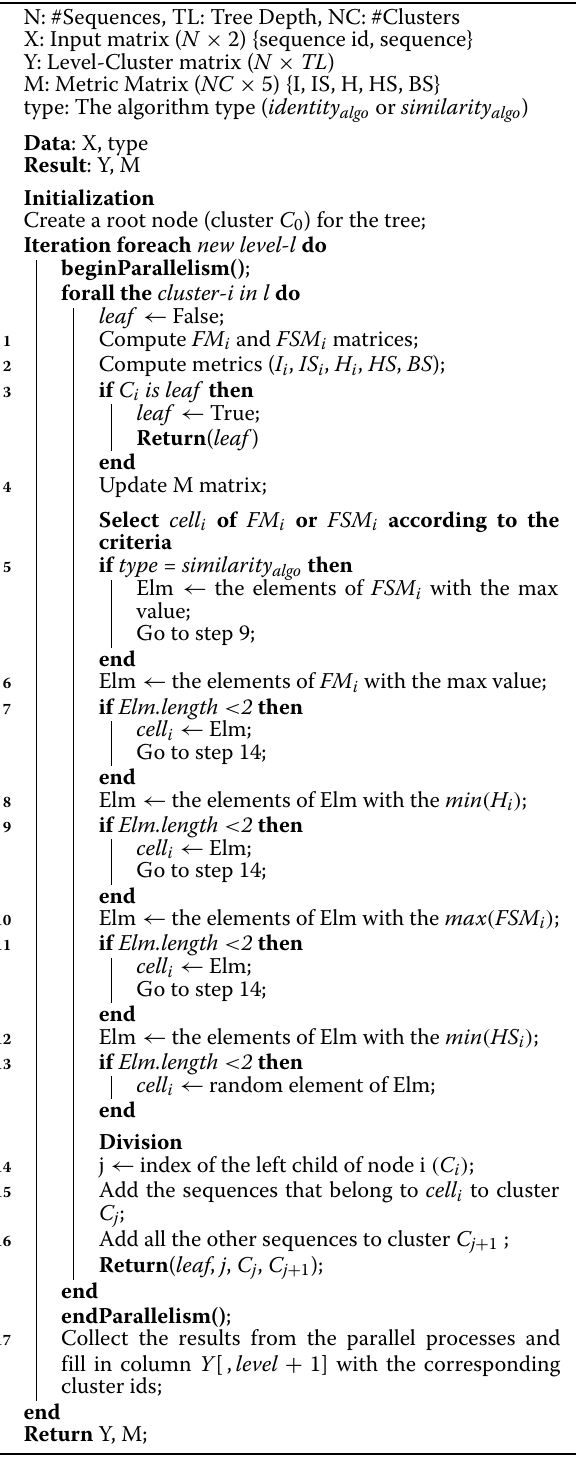
Algorithm 1: Binary Tree